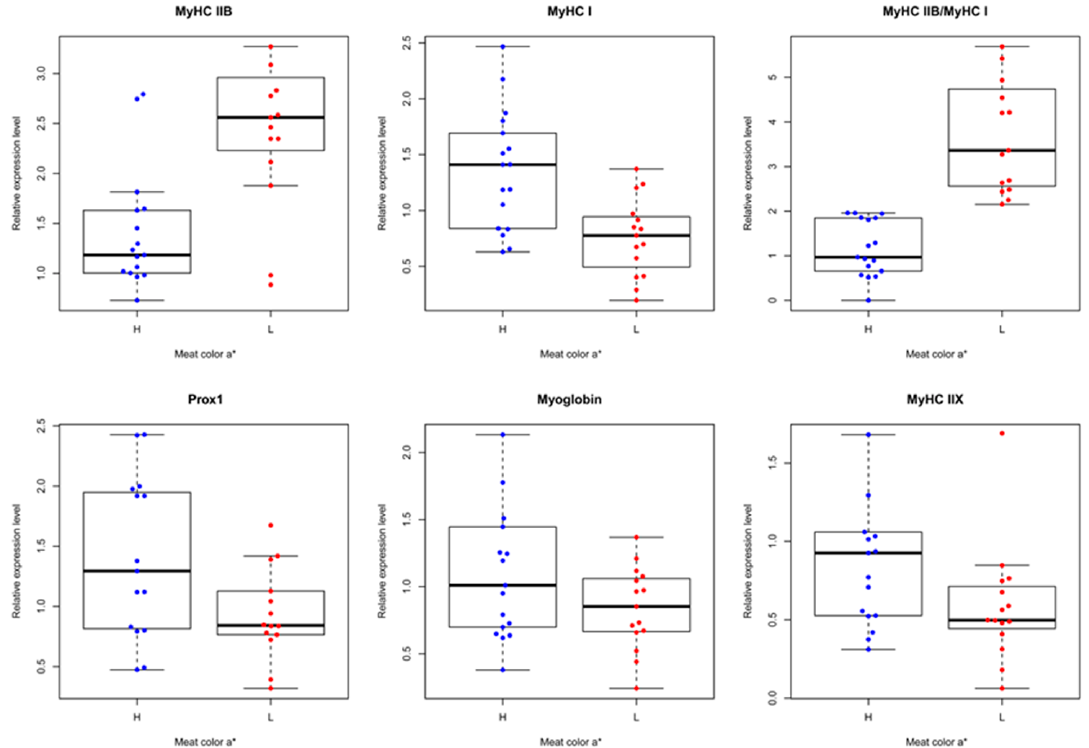
Figure 4. Comparison of porcine Prox1 expression to that of skeletal muscle-fiber-related genes. Thirty-two longissimus dorsi muscles from a population of 279 commercial hybrid pigs were randomly selected, and the expression patterns of porcine Prox1 and skeletal muscle-fiber-related genes (including myoglobin , MyHC I , MyHC IIB , and MyHC IIX ) were determined using real-time PCR. All PCR reactions were performed in triplicate for each sample. The relative expression levels were calculated using the 2 −(cid:52)(cid:52) ct value method and normalized with the porcine housekeeping gene HPRT . The samples were divided into two groups according the ratio of MyHC IIB to MyHC I expression level, which was set at